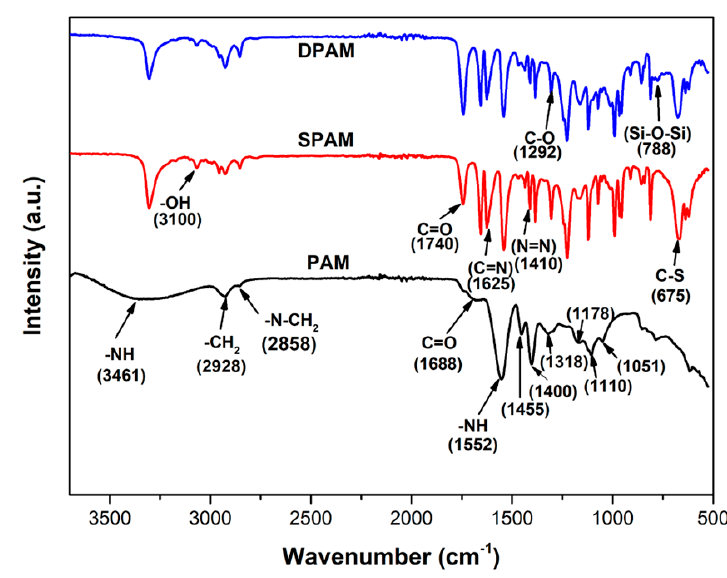
Figure 5. FTIR spectrum of PAM, SPAM, and DPAM.